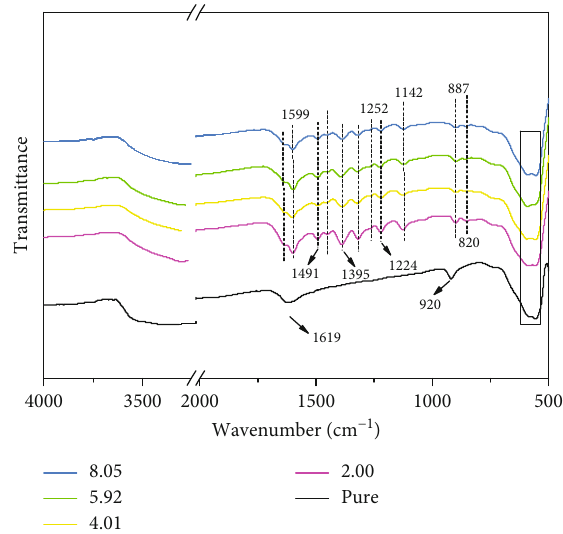
Figure 6: FTIR spectra of acid δ -MnO after reaction with MB at di ff erent pH (2.00, 4.01, 5.92, and 8.05).